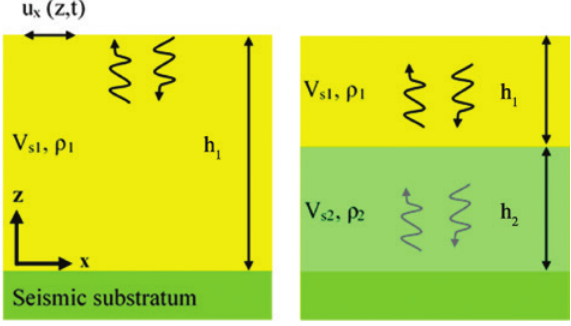
Figure 10: Schematics of wave propagation in a 1D soil-model. Homogeneous (left), two-layers model (right).